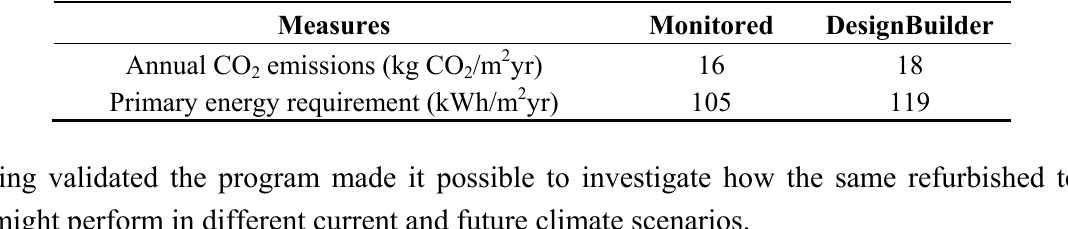
Table 4. Monitored results and DesignBuilder predictions for the refurbished terraced